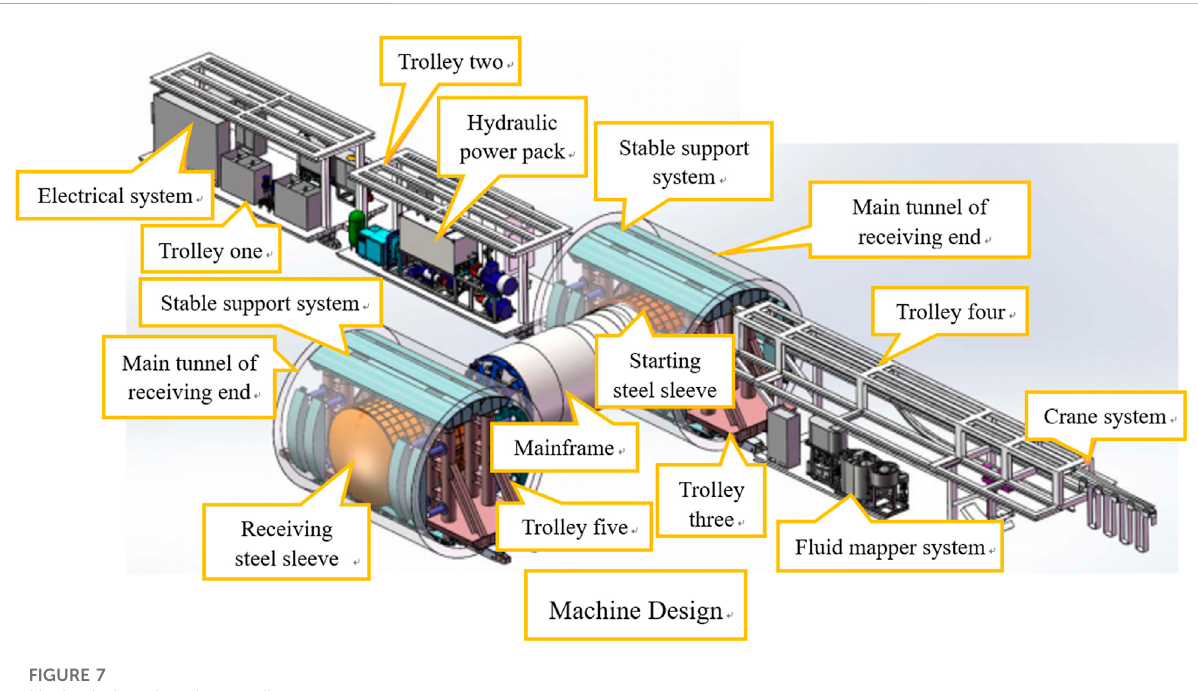
FIGURE 7 Mechanical total equipment diagram.